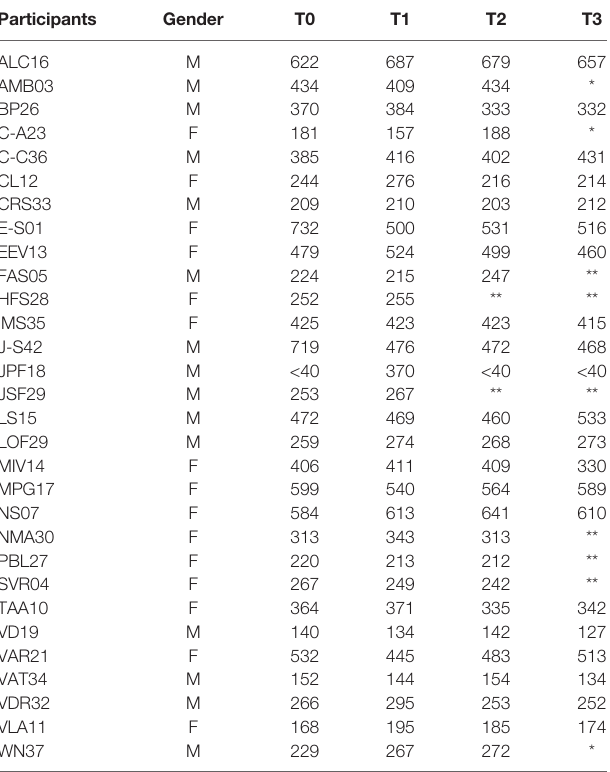
TABLE 7 | Evaluation of the plasma concentration of Immunoglobulin A (IgA) in mg/dL of 30 participants # at T0, T1,T2, and T3. Participants